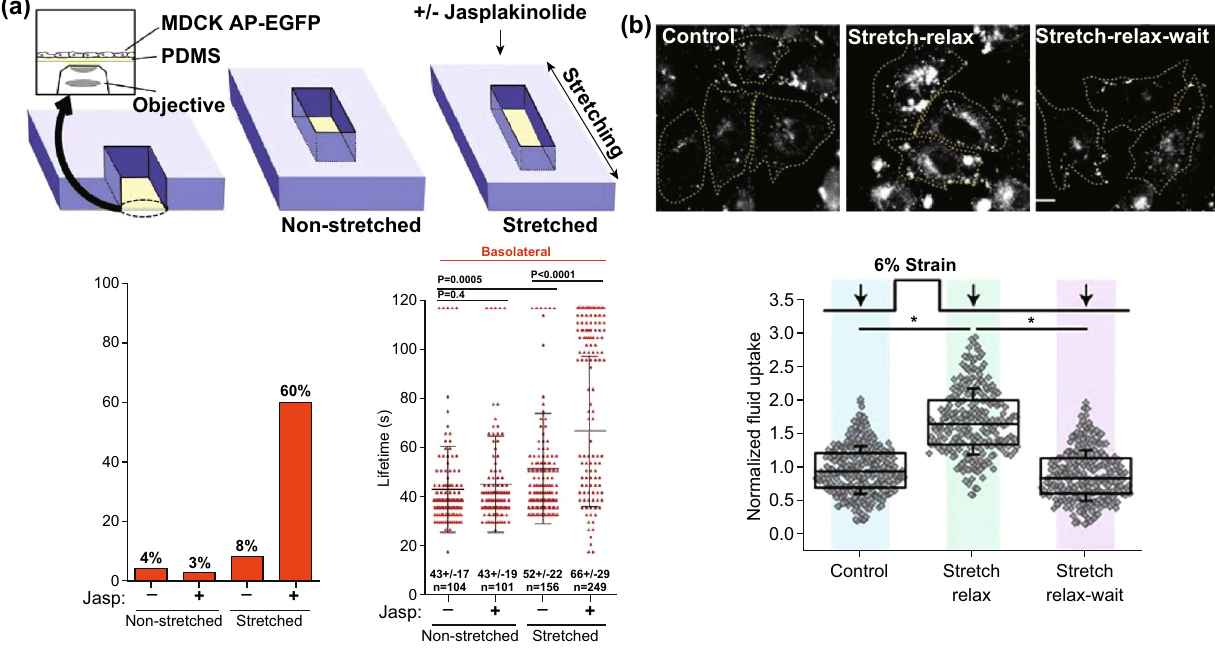
Fig. 11 Effect of membrane tension differences on cellular endocytosis. a Jasplakinolide treatment increases pit lifetime and percentage of arrested pits of stretched cells, adapted from Ref. [104] with permission. b Stretching regulates F-Dex uptake, adapted from Ref. [105] with per-